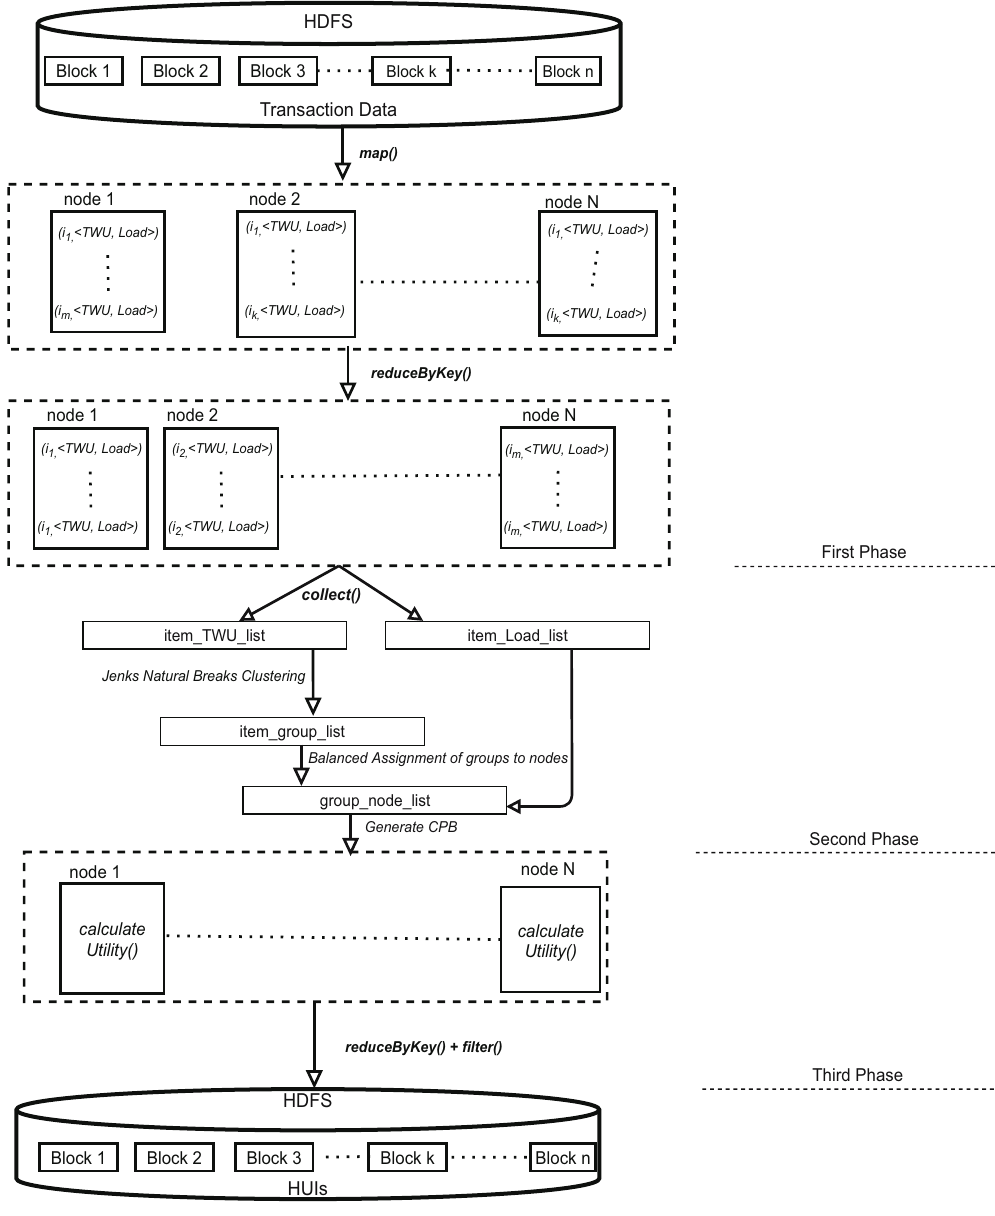
Figure 3: Flow of parallel utility computation